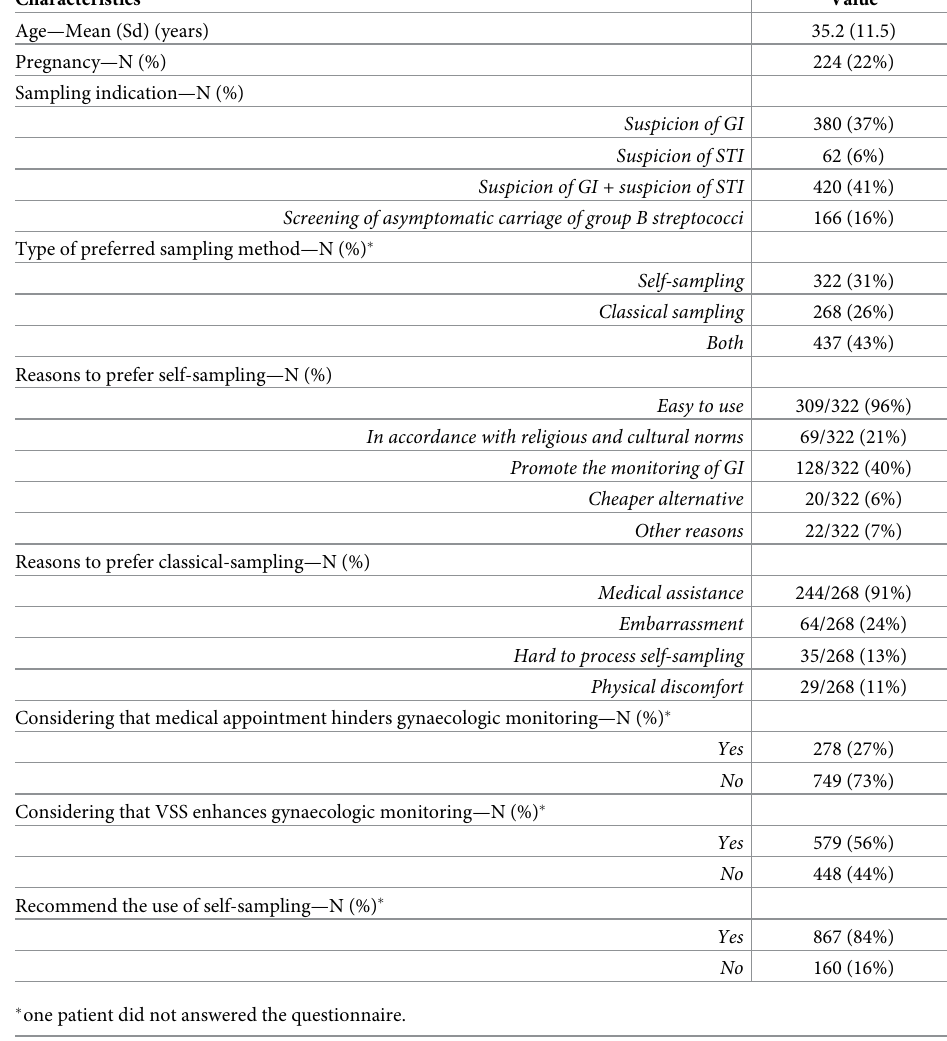
Table 1. Characteristics of surveyed